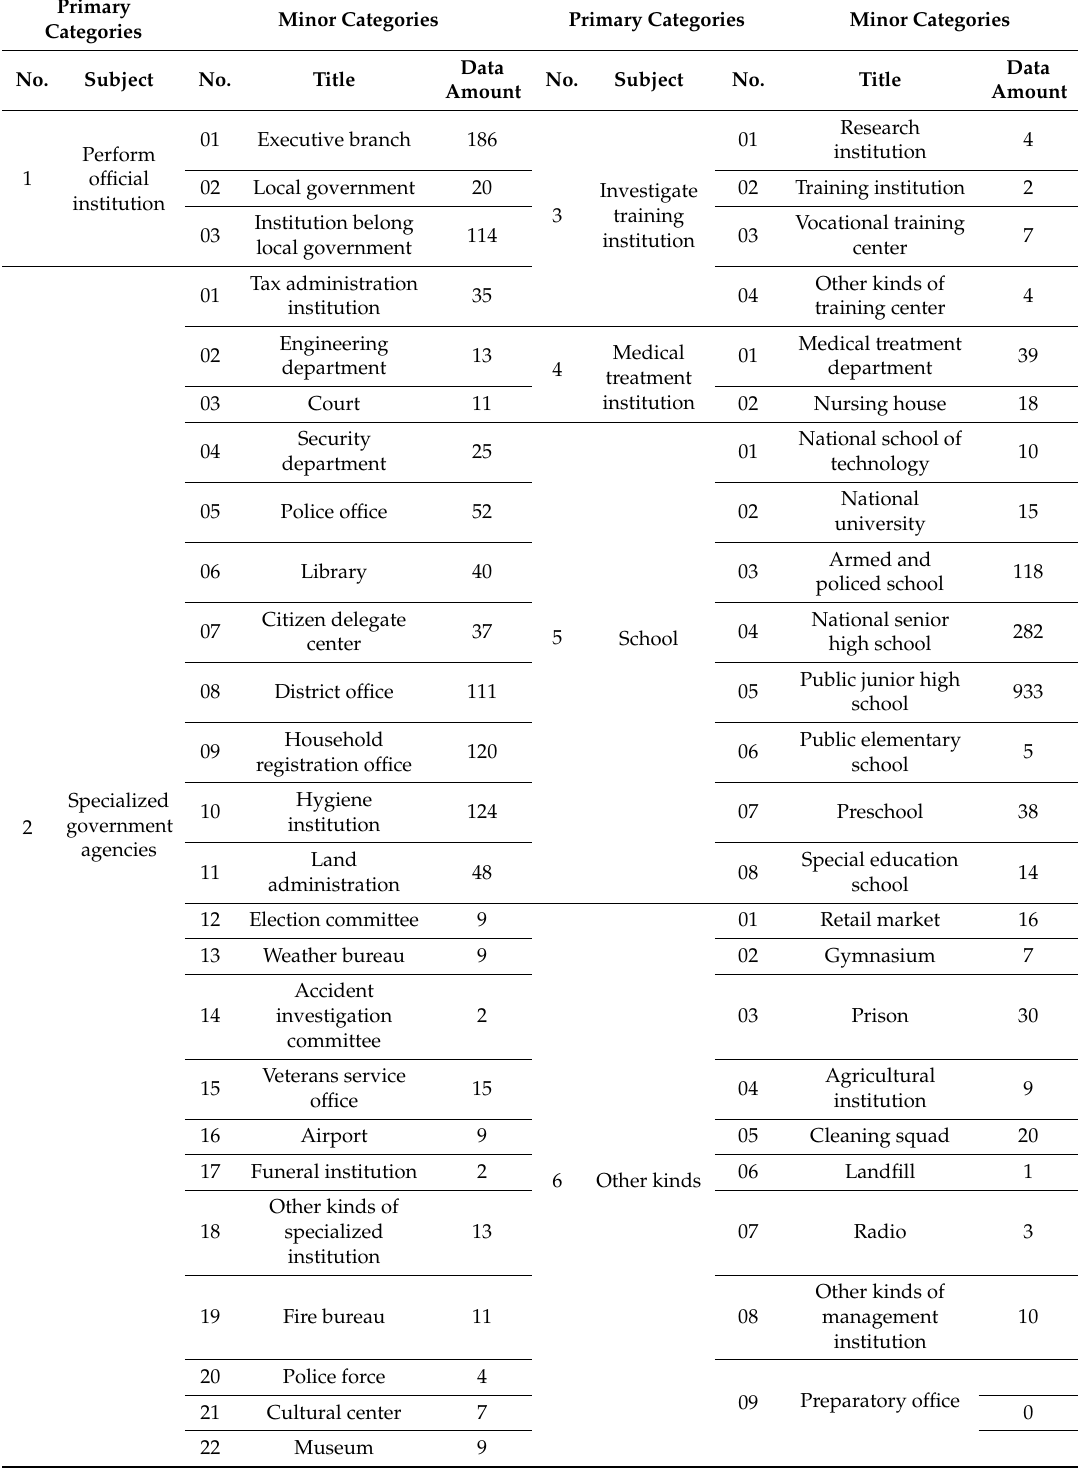
Table 2. Categories of government